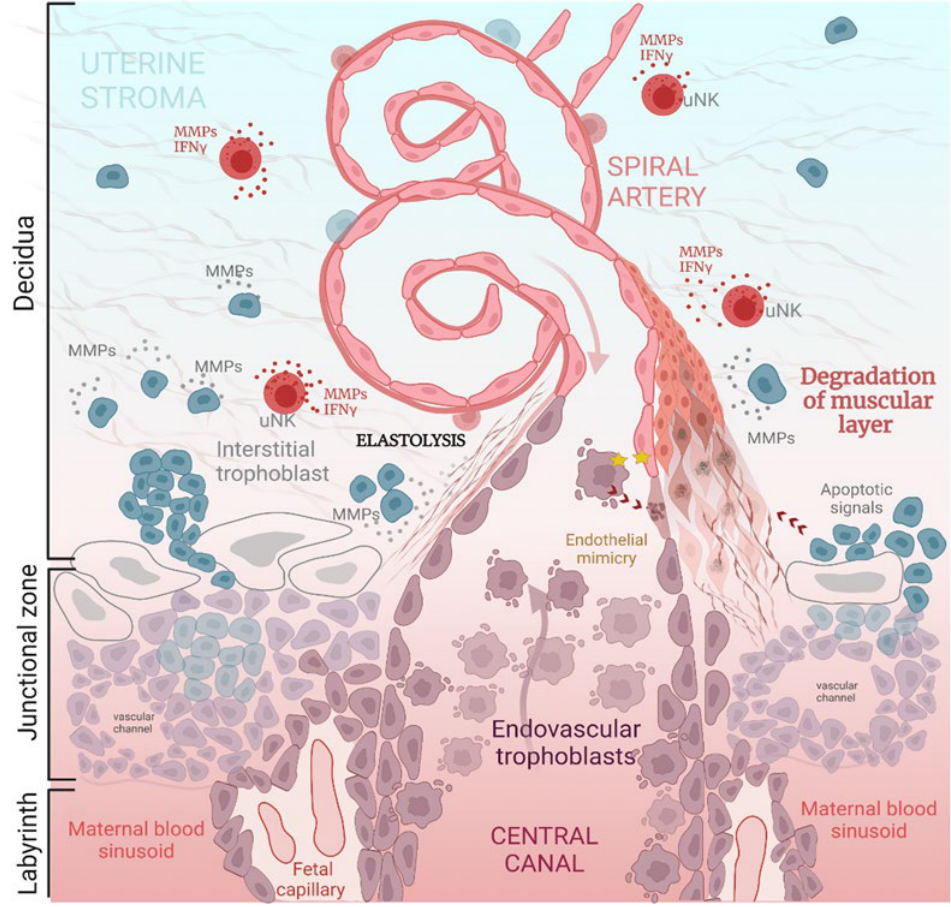
Figure 3. Schematic representation of the main mechanisms of spiral artery remodeling (SAR) in mice. Two main pathways of SAR are represented: the interstitial invasion of trophoblasts into the maternal decidua and the endovascular invasion of trophoblasts into the spiral arteries. The spiral arteries are partially invaded and then remodeled in the central canal by endovascular trophoblasts, which are called SpA-TGCs in mice (extravillous trophoblasts (EVTs) in humans). In addition, they infiltrate and replace endothelial cells via several mechanisms: endothelial mimicry, the induction of apoptosis, and the secretion of MMPs. They also induce the degradation of the vascular muscular layer and thus transform the spiral arteries into a central trophoblast-lined canal that carries maternal blood to the placental labyrinth. The maternal decidua is remodeled by interstitially invasive GlyT cells that originate from spongiotrophoblast (SpT) cells in the junctional zone. In addition, in mice, the junctional zone contains a layer of P-TGC cells that directly overlie the decidua but also the SpT and GlyT cells that surround the vascular channels and the central canal. Indeed, the invasive GlyTs secrete several MMPs and thus modify the composition of the uterine extracellular matrix. These GlyTs also induce the degradation of the arterial basal membrane (elastolysis) and SMCs. In addition, the decidual layer contains uNK cells, which participate in the SAR by secreting INFγ and MMPs. GlyT: glycogen trophoblast cell; uNK: uterine natural killer; SpA-TGC: spiral-arterial-associated trophoblastic giant cell; SpT: spongiotrophoblast; P-TGC: parietal trophoblast giant cell; EC: endothelial cell; SMC: smooth muscle cell; ECM: extracellular matrix; MMPs: matrix metalloproteinases; INF- γ: interferon gamma.